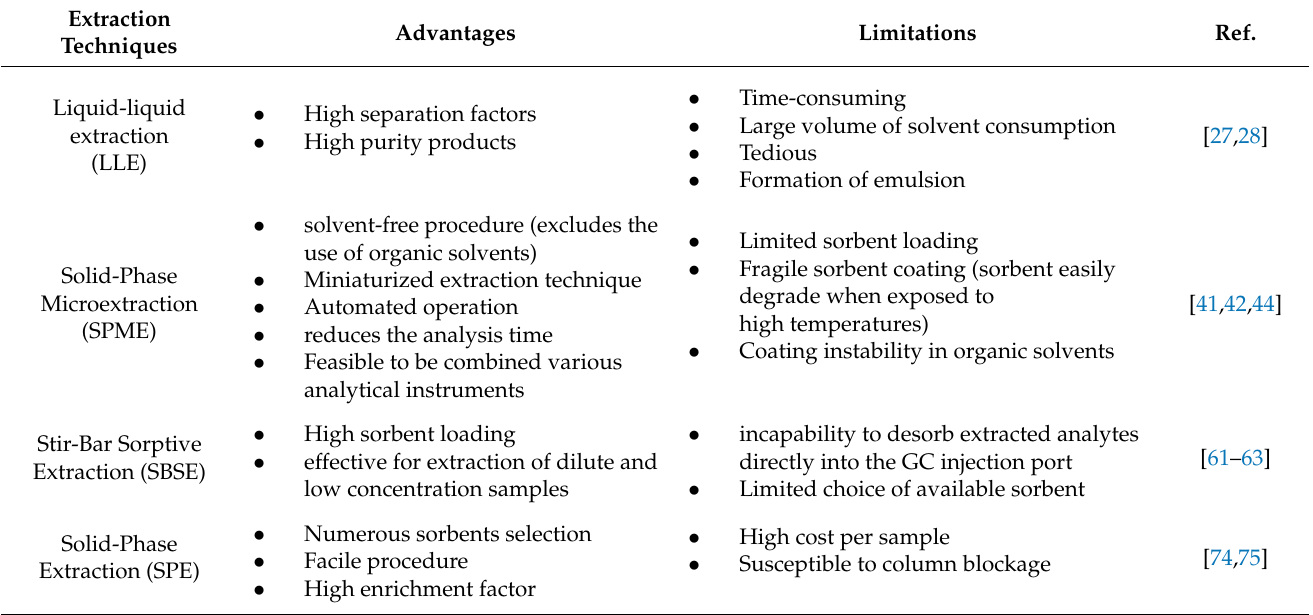
Table 6. Advantages and limitations of sample preparation techniques commonly used for determination of OPPs. Extraction Advantages Limitations Techniques